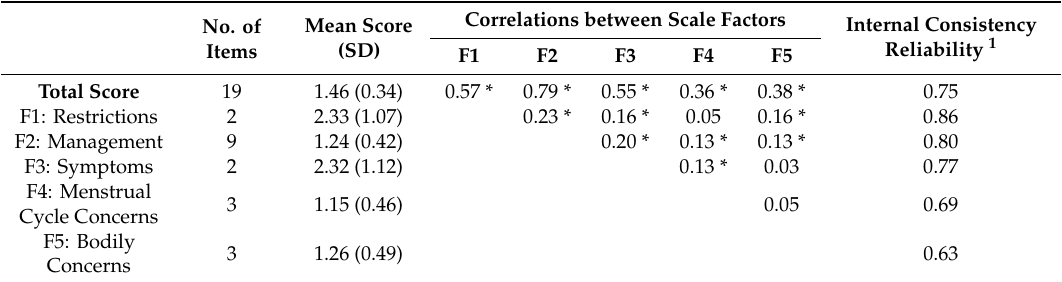
Table 4. Scale and Factor descriptive characteristics, inter-correlations, and internal consistency